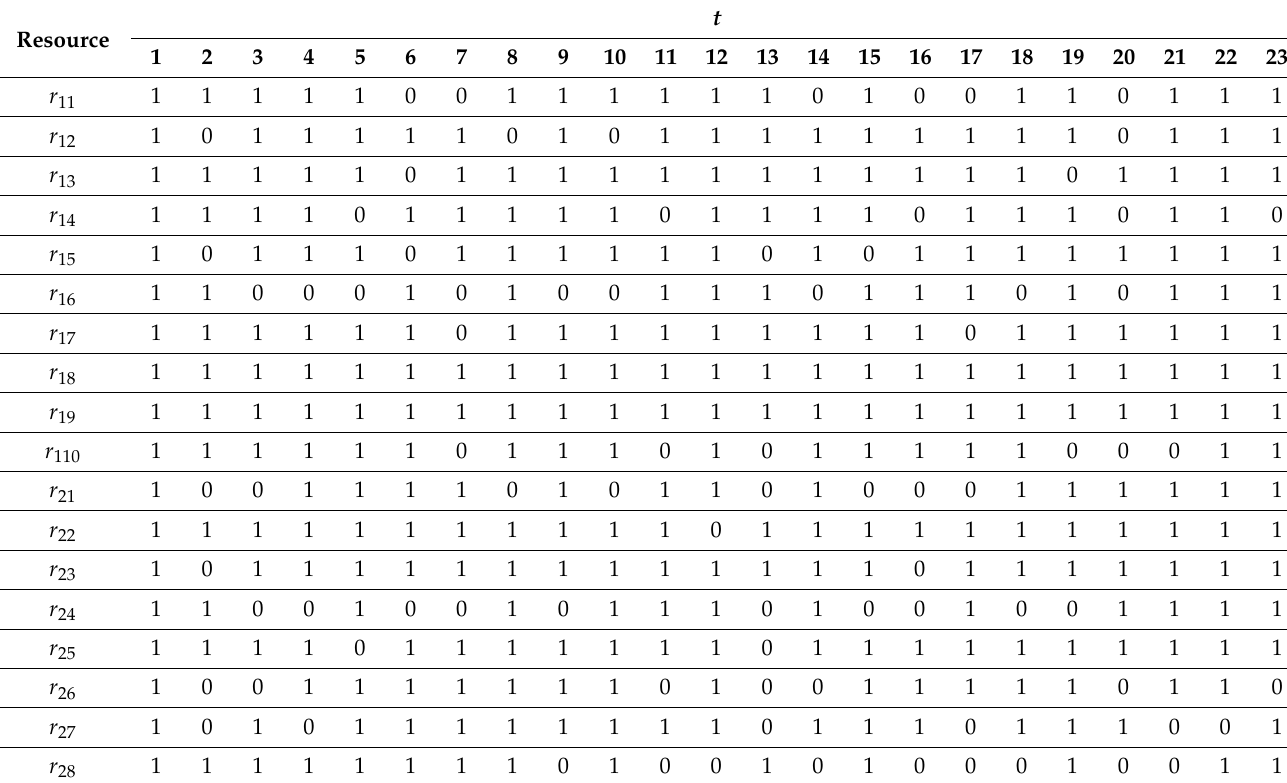
Table A2. The resource state